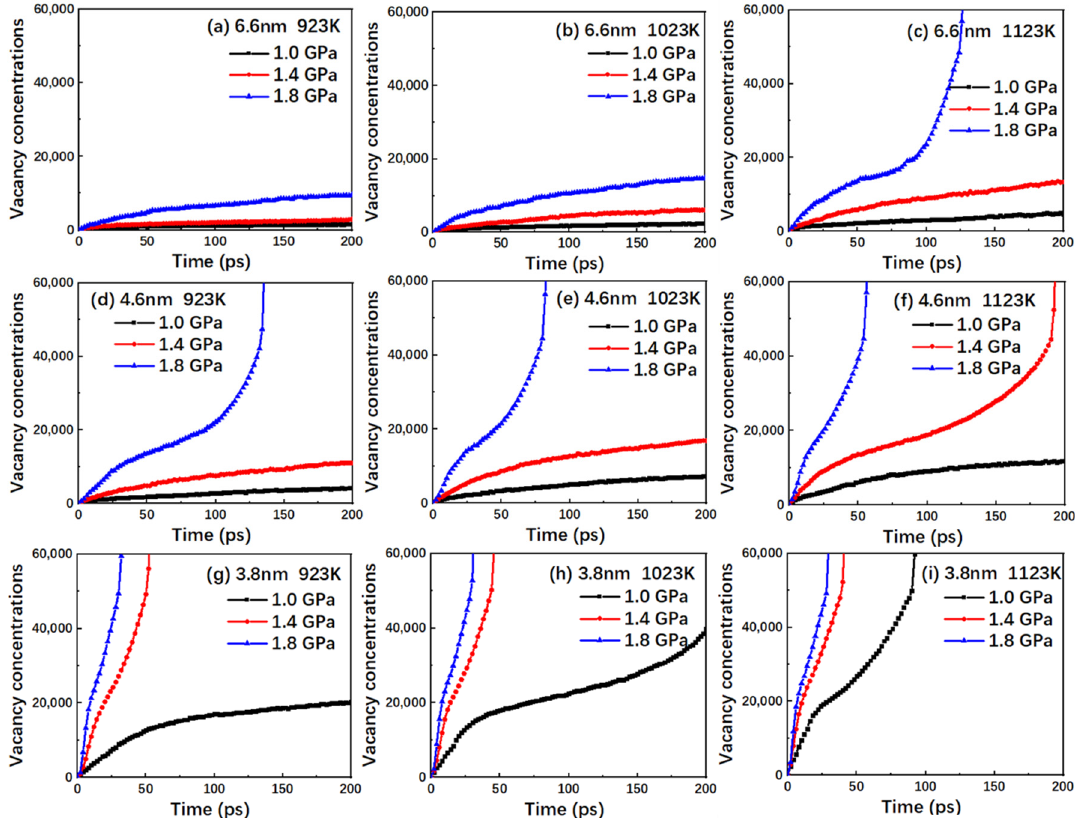
Figure 7. Plots of the vacancy concentrations versus time for the nanocrystalline TiAl models with grain sizes of ( a ) 6.6 nm at 923 K; ( b ) 6.6 nm at 1023 K; ( c ) 6.6 nm at 1,123 K; ( d ) 4.6 nm at 923 K; ( e ) 4.6 nm at 1023 K; ( f ) 4.6 nm at 1123 K; ( g ) 3.8 nm at 923 K; ( h ) 3.8 nm at 1023 K; and ( i ) 3.8 nm at 1123 K under the stress levels of 1.0, 1.4, and 1.8 GPa.